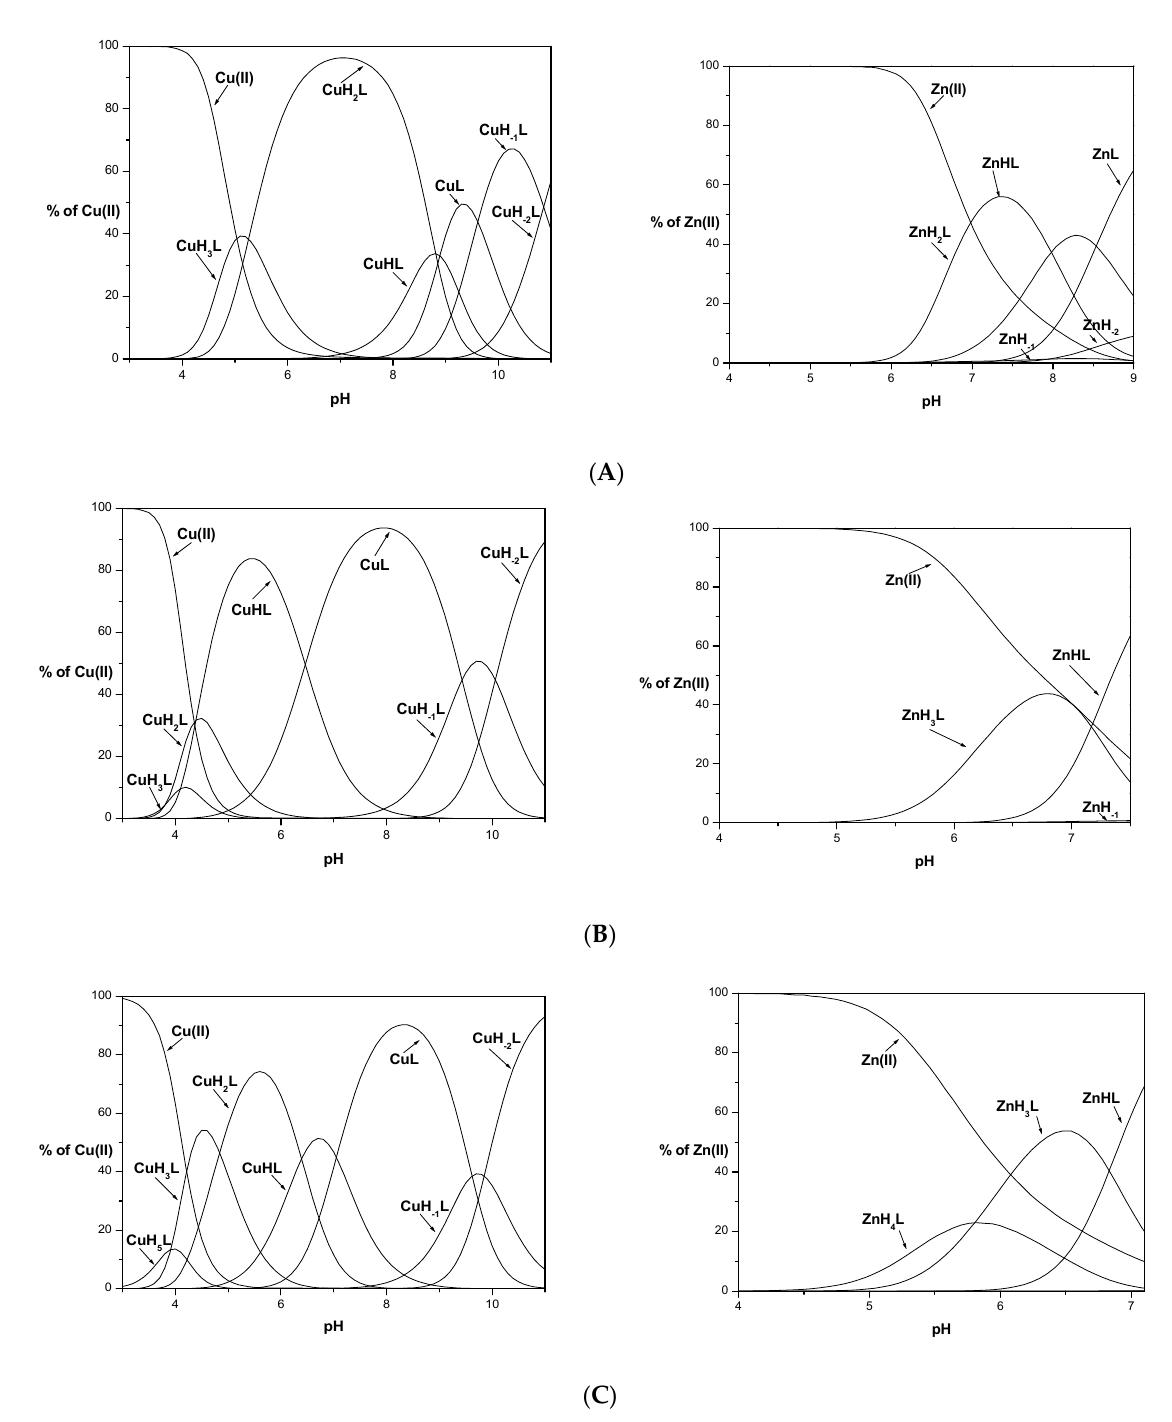
Figure 1. Species distribution of metal (Cu(II) and Zn(II)) complexes of KSAFELPHYGLLAHQ ( L1 ), ( A ) KSHFELPAYGLLAHQ ( L2 ), ( B ) and KSHFELPHYGLLAHQ ( L3 ), ( C ). M(II) to peptide molar ratio 1:1.1; T = 25 °C; I = 0.1 M; [M(II)] = [L1–3] = 0.001 M. Zn -1 H and Zn -2 H represent hydrolysis of Zn(II) ions.